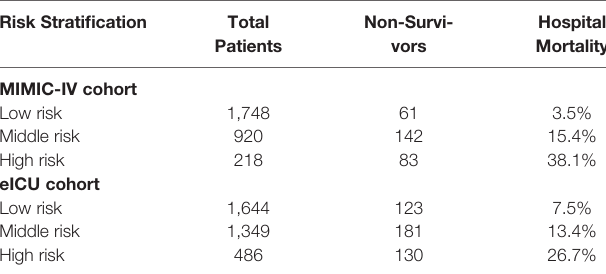
TABLE 4 | Risk strati fi cation using ASL in MIMIC-IV and eICU cohort. Risk Strati fi